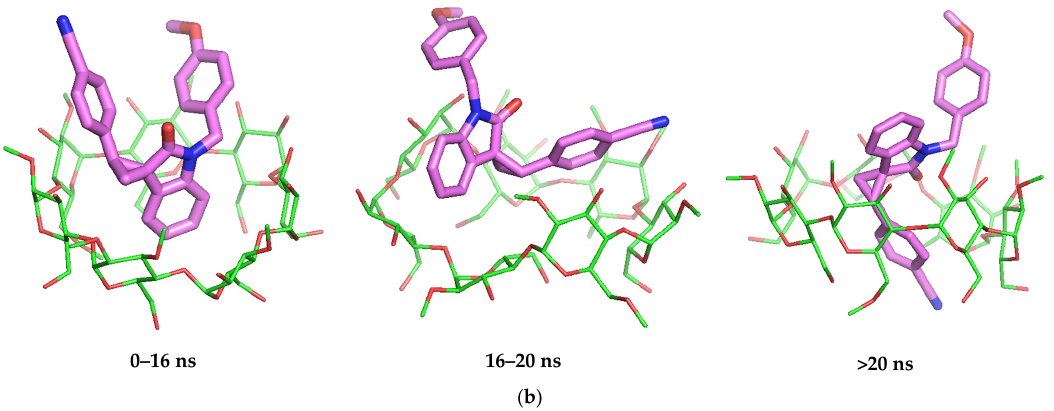
Figure 13. ( a ) Root-mean-square deviation (RMSD) and distance between the M β CD and 2b centers of geometry (Type III complex). ( b ) Type III complex structure transformation into Type II geometry.